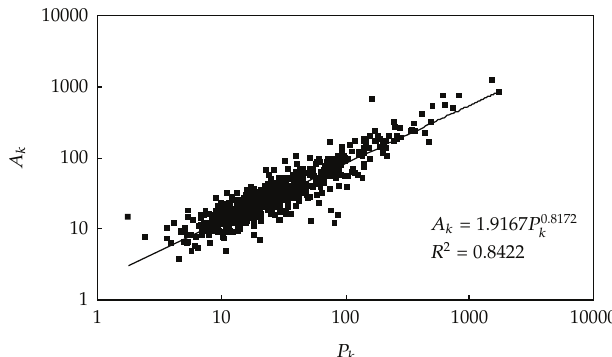
Figure 5: The allometric scaling relation between built-up area and urban population of China’s cities (cid:3) 2005 (cid:4) .